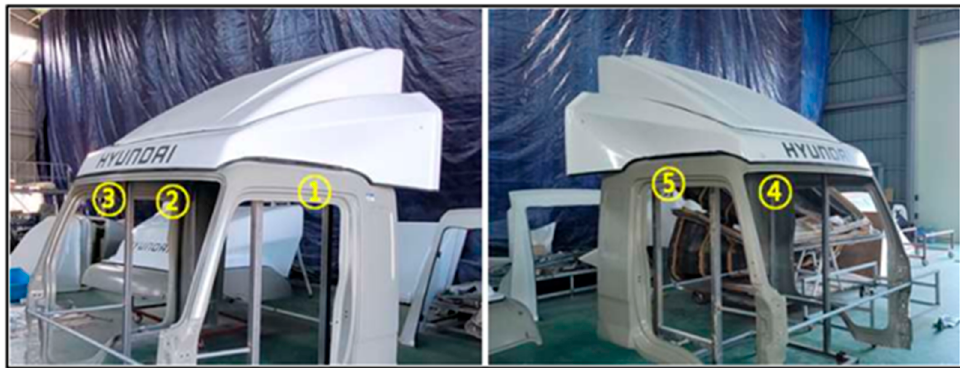
Figure 17. The measurement point for the tolerance test.